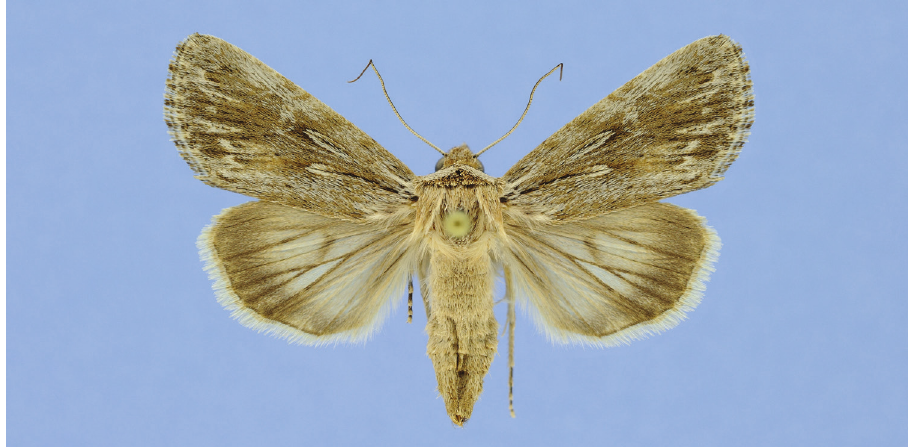
Figure 10. Sympistis riparia Morrison, Dartmouth, MA, ex larva . M.W. Nelson.